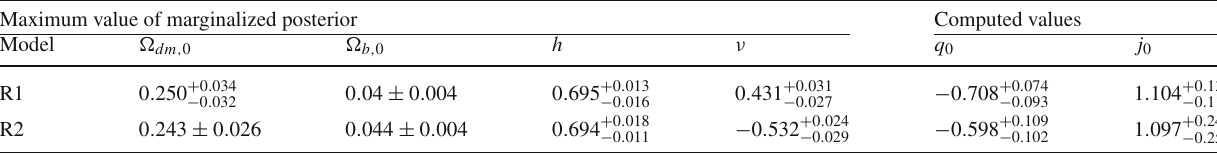
Table 4 The maximum value of marginalized posterior for each of the parameters of HDE models (left part) and the value of cosmographic parameters calculated upon maximum of the marginalized posterior (right part). We note that in these models we have L = H − 1 Maximum value of marginalized posterior